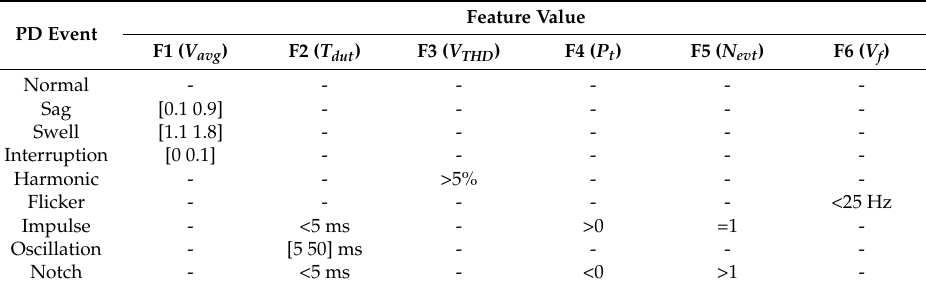
Table 1. Quantified eigenvalue classifier (QEC) of joint-domain dictionary mapping (JDM) for conducting power disturbance (PD)